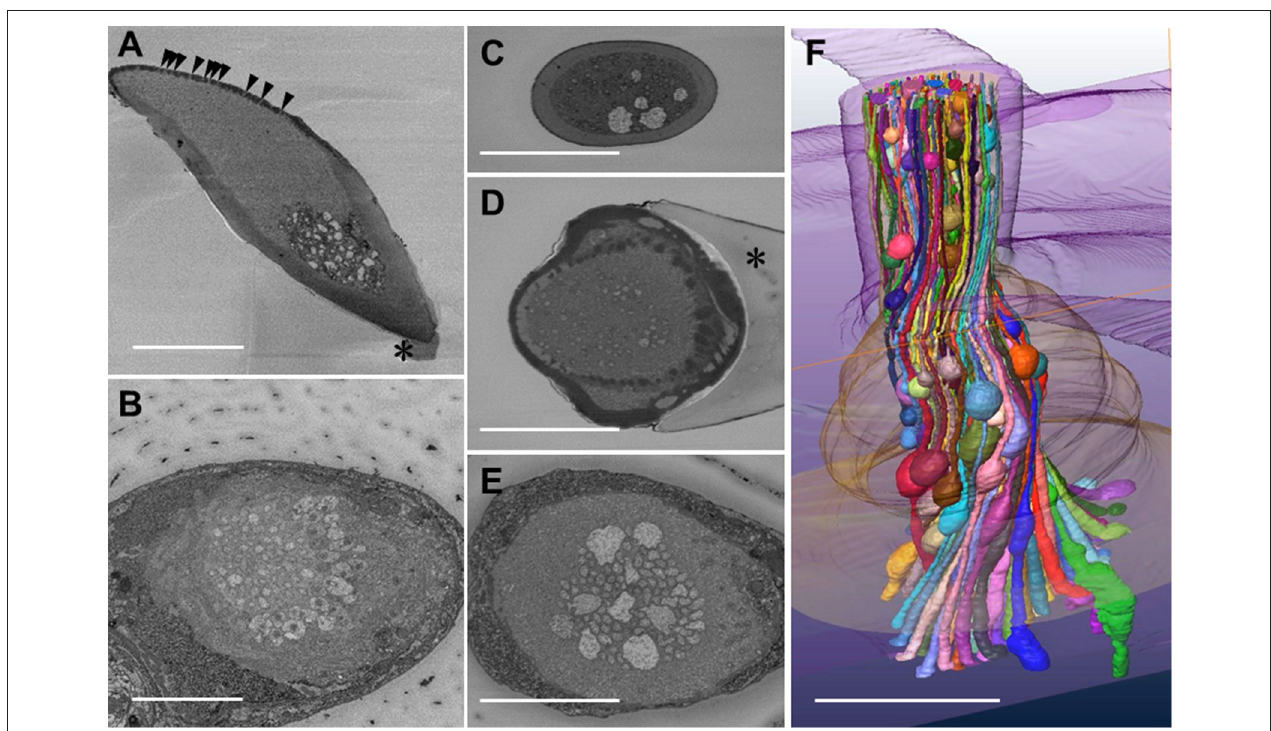
FIGURE 1 | Serial block face scanning electron microscope images and reconstruction of a three-dimensional structure of olfactory receptor neurons’ dendritic processes in a Sensilla basiconica of Camponotus japonicus worker ant. (A) A longitudinal oblique section of the S. basiconica . Arrowheads and asterisk indicate openings of olfactory pores and a part of the socket cuticle at the basement of the sensillar shaft, respectively. (B) A cross image of the S. basocinica with 102 dendritic processes at the junction with the inner segments of ORNs. (C–E) The cross images of S. basiconica at 6 and 1 µ m distal and 4 µ m proximal from the outer surface of the antennal cuticle (see arrowheads of Figure 6A ). (F) 3D-structural model of a bundle of color-coded dendritic processes within a sensillum reconstructed by 352 cross images at 70nm interval (24.6 µ M in total length). Bars indicate 5 µ